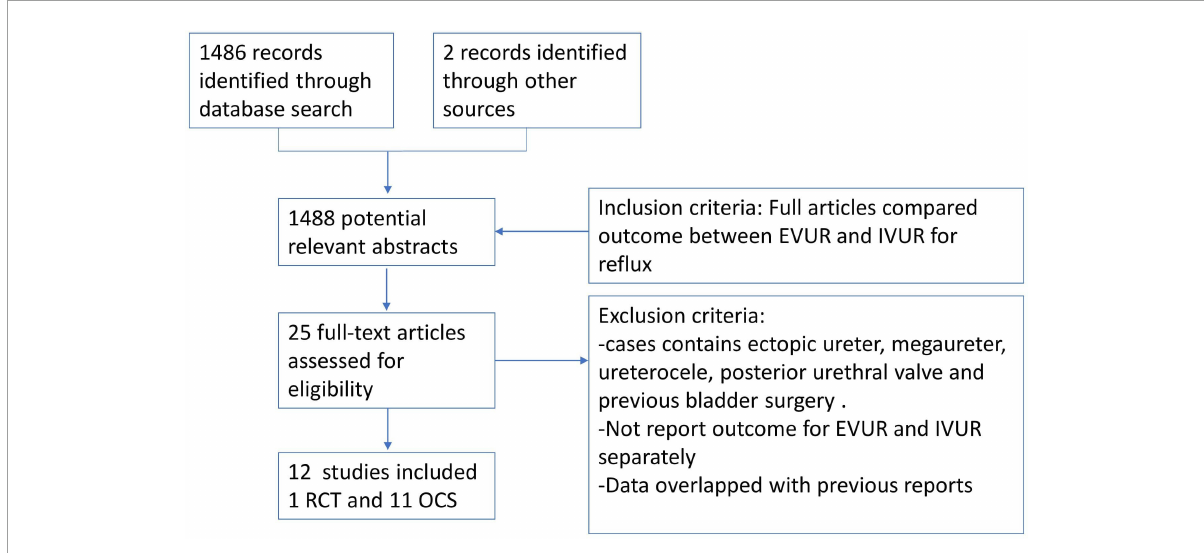
FIGURE1 Preferred Reporting Items for Systematic Reviews and Meta-Analyses (PRISMA) flowchart of selection of